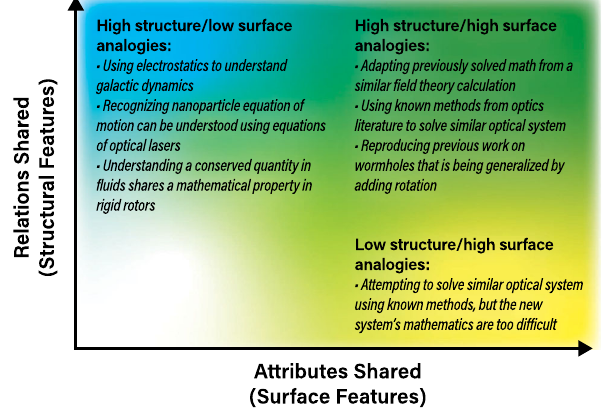
FIG. 4. Several instances of analogy usage that we identified, mapped onto the analogy space presented in Fig. 1. Analogies in the upper left corner labeled high structure and low surface were mathematical analogies between systems from “ distant ” domains of physics (e.g., electrostatics and galactic dynamics). The upper right side of the diagram illustrates analogies between highly similar systems on both levels (e.g., adapting previously solved calculations from within the theorist ’ s subfield). Other analogies fell on a spectrum between the upper right and lower right corner, depending on the degree to which the theorist needed to change their mathematical approach to the new